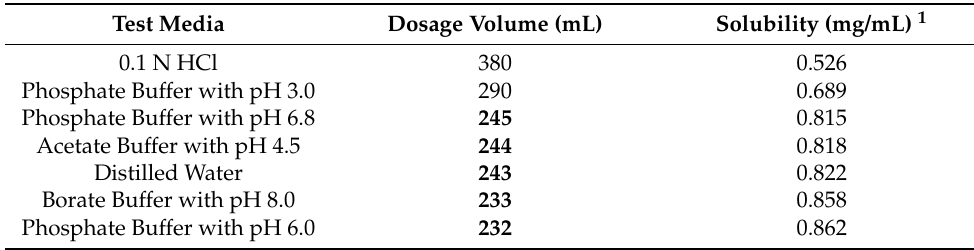
Table 2. Solubility results of favipiravir in different proposed dissolution